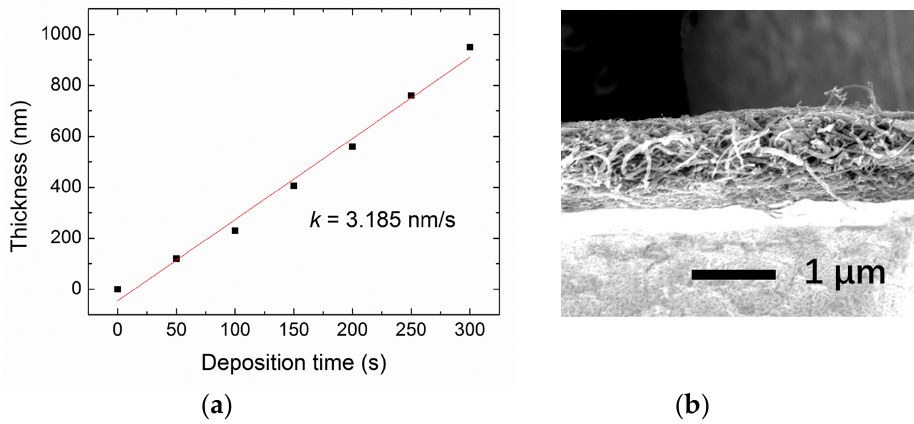
Figure 4. ( a ) Dependence of the thickness of the PEI nanofiber layer on the deposition time; ( b ) Typical cross-view SEM image of the PEI nanofiber layer with the deposition times of 300 s.